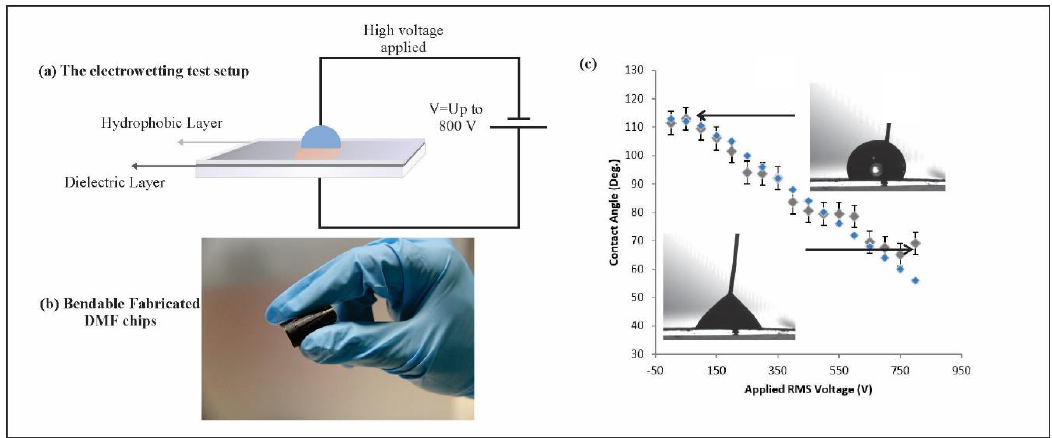
Figure 3. ( a ) The electrowetting test setup. ( b ) The fabricated chips were bendable, which could allow the droplets to move in inclined, twisted and vertical directions. ( c ) The electrowetting test performed to characterize the change in the contact angle. Blue dots represent the trend line, where the contact angle saturation occurred at 70 degrees.